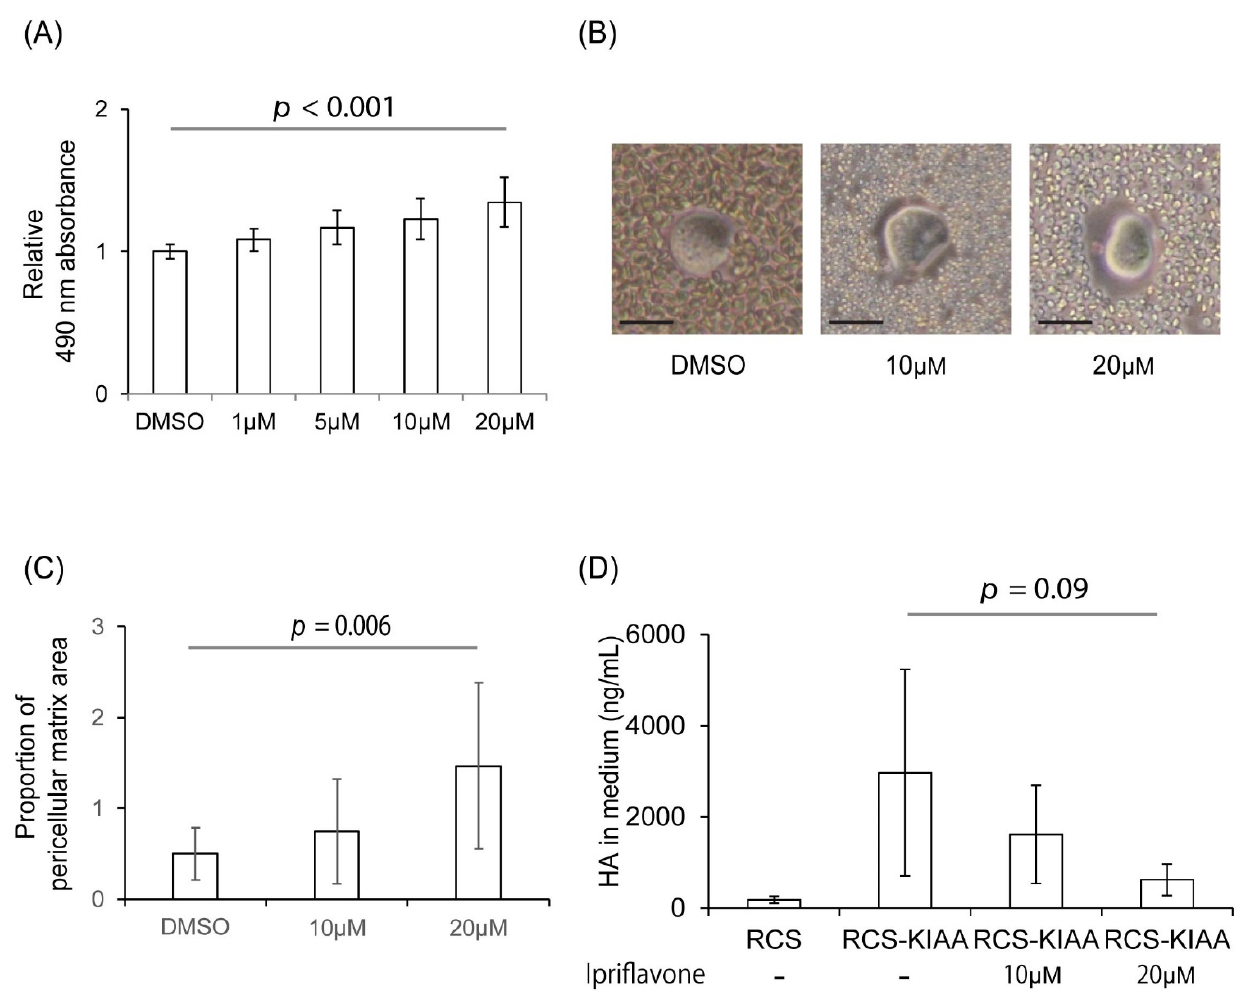
Figure 1. Effects of Ipriflavone on the Alcian blue staining and pericellular matrix formation of KIAA1199-transfected RCS (RCS-KIAA) cells. Mouse KIAA1199 cDNA was transfected in RCS cells.